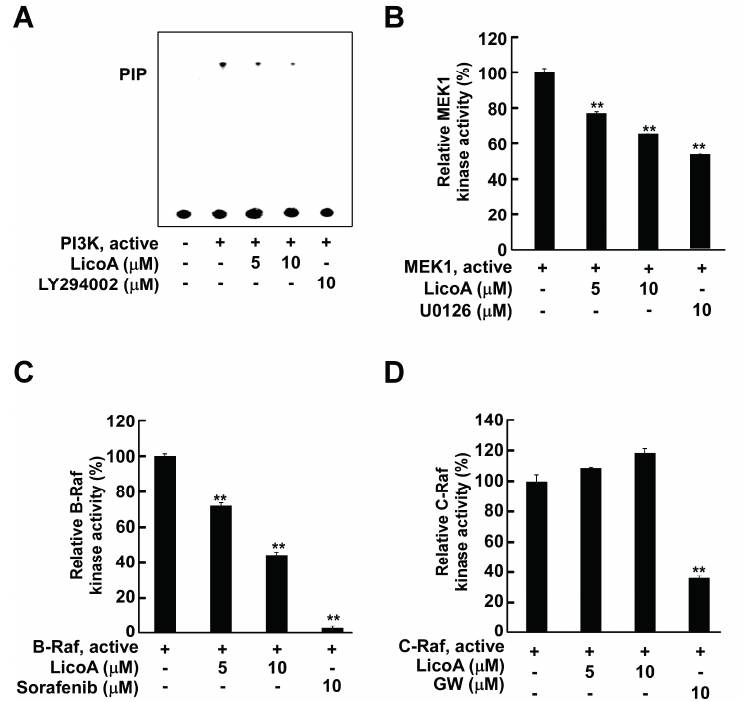
Figure 3. Effect of LicoA on phosphoinositide 3-kinase PI3K, MEK1, B-Raf, and C-Raf kinase activity. ( A ) LicoA inhibits PI3K activity. Active PI3K (100 ng) was